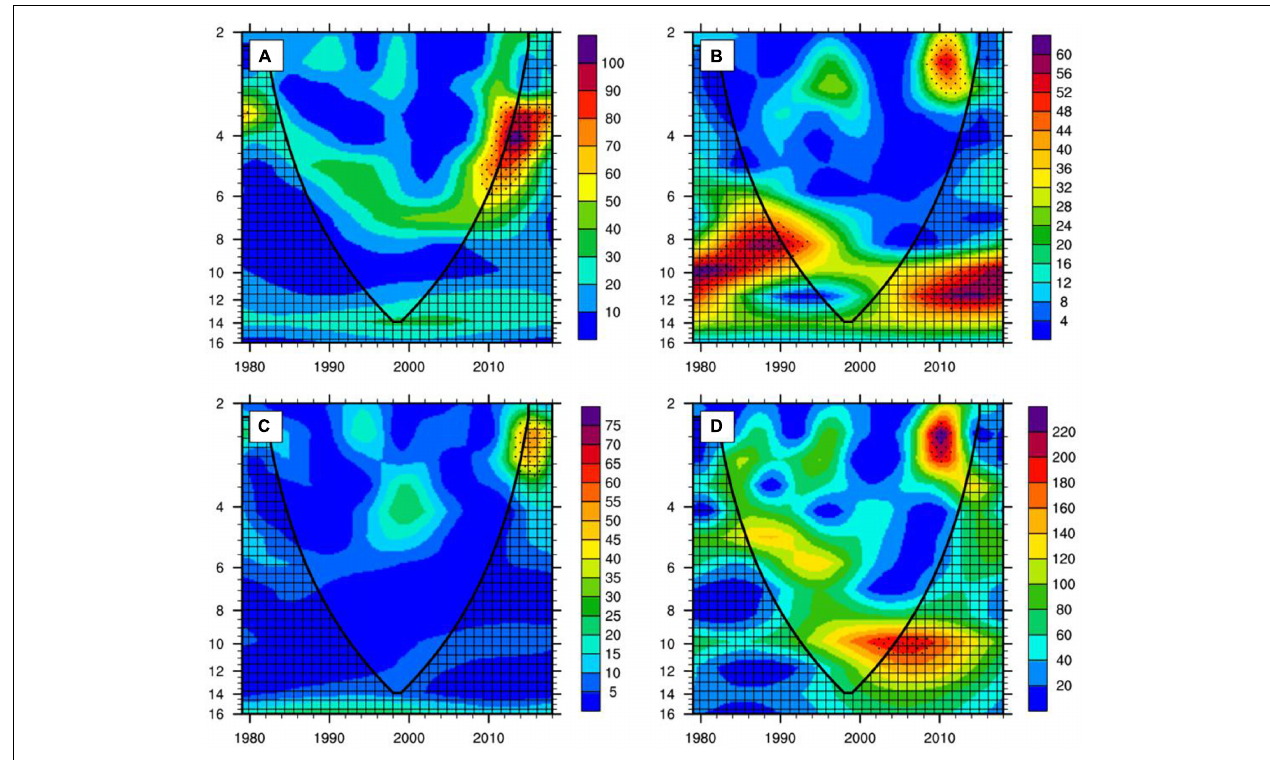
FIGURE 3 | The wavelet analysis spectrogram of the four types of NCCV during 1979–2018: (A) EM type; (B) SLM type; (C) ESM type; (D) SSM